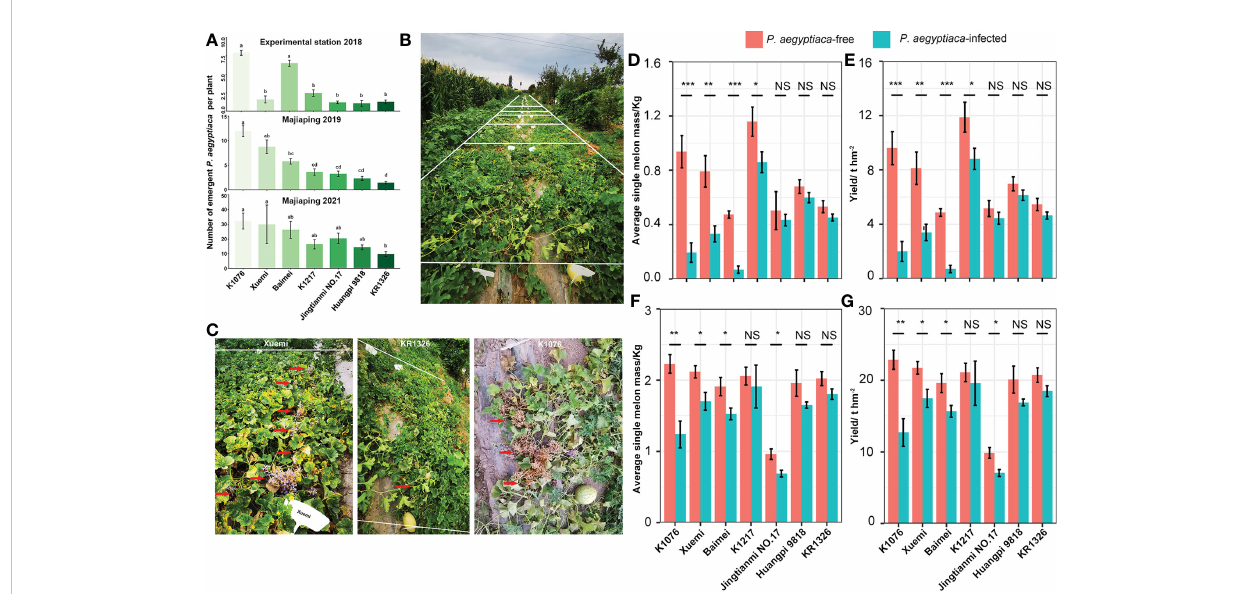
FIGURE 3 The resistance response of melon cultivars to P. aegyptiaca at the experimental station and Majiaping fi eld sites. K1076, Xuemi, Baimei, K1217, Jingtianmi No.17, Huangpi 9818, and KR1326 were used in the fi eld trials. (A) The number of emerged P. aegyptiaca plants per cultivar for the experimental station in 2018 and Majiaping in 2019 and 2021. Data presented are means ± SE. The letters above each bar indicate signi fi cantly different ( P ≤ 0.05) groups after Tukey ’ s HSD test. (B) Contrasting P. aegyptiaca infection levels in the P. aegyptiaca screening trial at Majiaping (July 2021) replicate 3; sub-plots, representing cultivars are delimited by white lines. (C) The growth of Xuemi, KR1326, and K1076 at Majiaping (July 2021). Red arrows represent the emerged P. aegyptiaca shoots. (D, F) Single melon mass (Kg) per cultivar for the experimental station in 2018 and Majiaping in 2021. (E, G) Melon yield (t ha -1 ) per cultivar for the experimental station in 2018 and Majiaping in 2021. Data presented are means ± SE. NS, *, **, *** indicate signi fi cant differences at P > 0.05, P < 0.05, P < 0.01, and P < 0.001 respectively, by Student ’ s t test within a